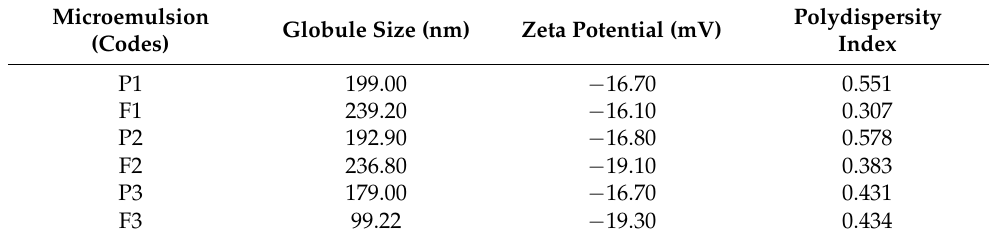
Table 5. Characterization of placebo and active microemulsions.